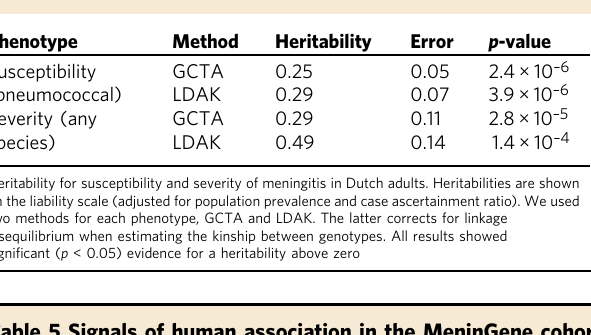
Table 5 Signals of human association in the MeninGene cohort Phenotype Position (SNP)